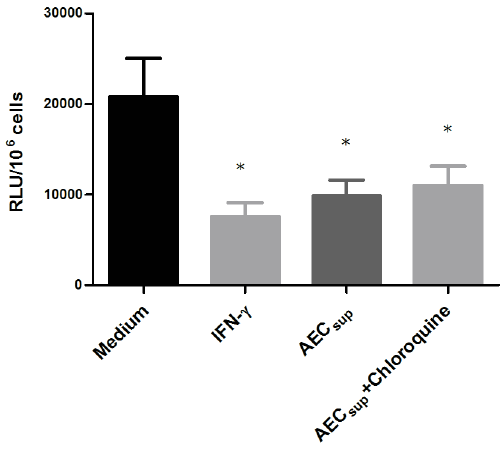
Figure 8. Inhibiting phagosomal acidification does not affect intracellular killing of BCG. BMM and PuM were infected with GFP- BCG. After infection, cells were treated with either IFN- c or AEC sup with or without chloroquine (10 m M). Bacterial growth was evaluated by determining RLU. Values are expressed as means 6 SD from 5 wells. The data is representative of 2 independent experiments. Differences between treatments analyzed using a one-way ANOVA followed by Bonferroni’s Multiple Comparison Test. * significantly different from medium control, P , 0.05. macrophages by iNOS-independent mechanisms that may be linked with to an intermediate M1-M2-like macrophage. Figure S1 Effect of either pretreating PuM with IFN- c before (IFN- c Pre Inf), or after infection (IFN- c Post Inf). PuM were either pretreated with IFN- c (20 ng/ml) for 24 h before infection or left untreated. Cells were then infected with GFP- BCG for 4 h. After infection, cells were thoroughly washed and treated with gentamicin for 30 min. After additional washing, cells were either cultured in complete medium (Medium) or in medium with IFN- c (20 ng/ml) or in medium with AEC-derived supernatant (AEC sup 1:2 diluted) for 48 h. Bacterial growth was evaluated by determining RLU in cell lysates. Data are shown as RLU/10 6 . Values are means 6 SD of the mean from 2 independent experiments. Differences were analyzed with a one- way ANOVA. * significantly different from Medium. (TIF)